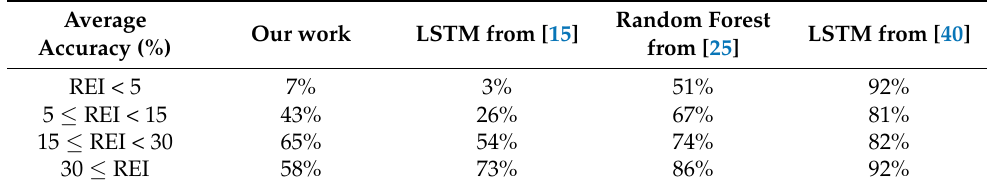
Table 10. REI estimation performance in comparison with LSTM from [15], Random Forest from [25] and LSTM from [40].